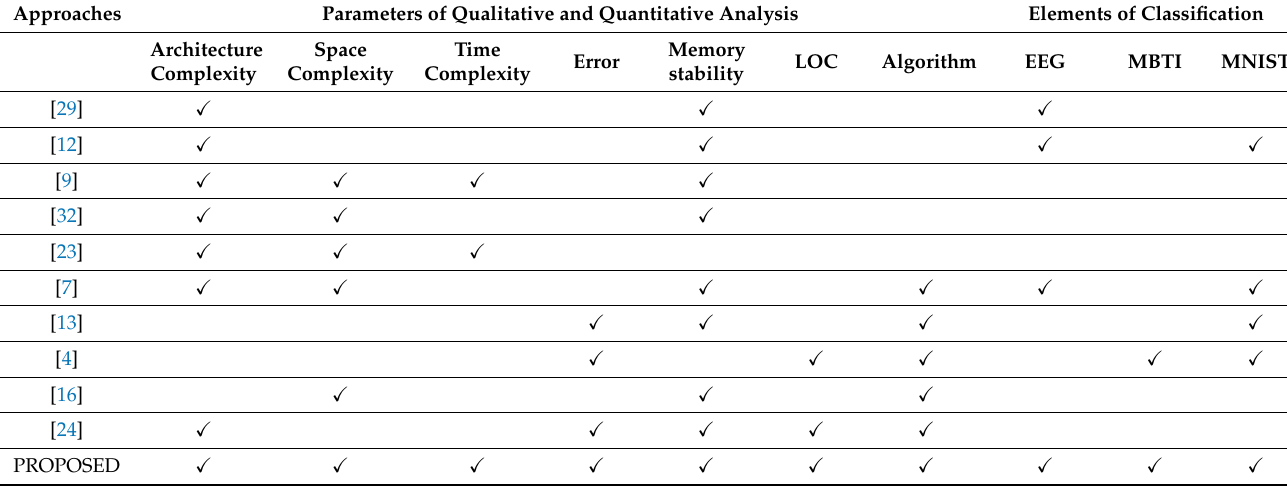
Figure 11. ROC graph of logistic regression classifier on Deep dataset. Table 3. Comparison of another state-of-the-art method.